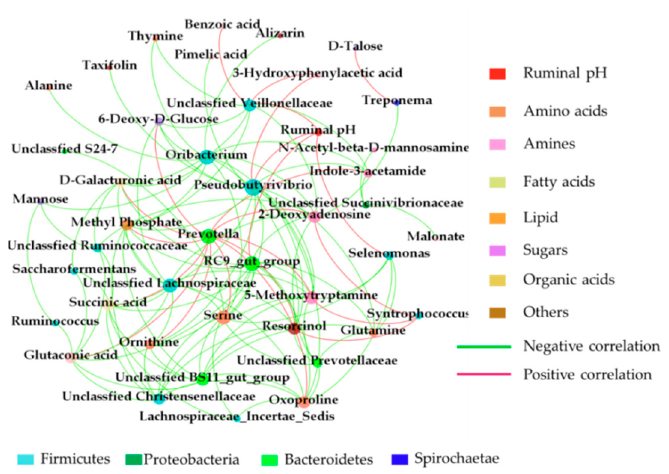
Figure 6. The spearman correlation network between ruminal microbiome and metabolome in CON and TR groups. The correlation coefficients with a statistical P value < 0.05 and the absolute value > 0.75 were used to build the network graph.